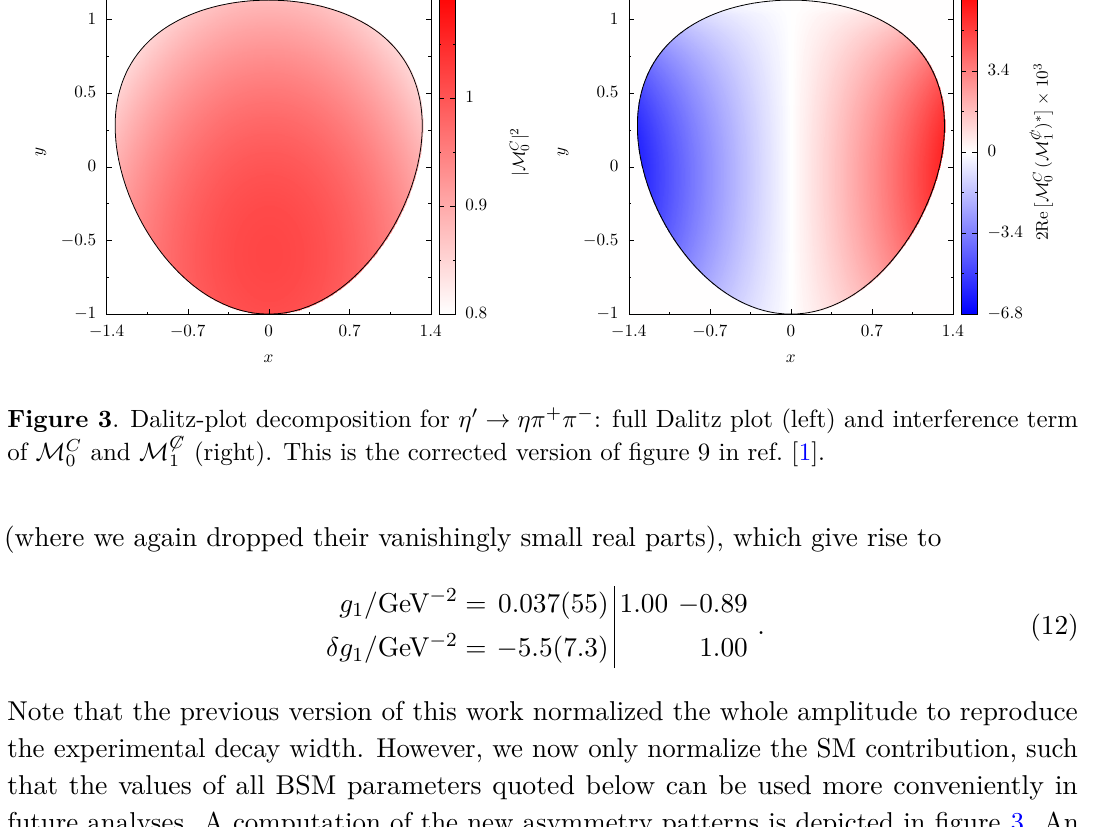
(where we again dropped their vanishingly small real parts), which give rise